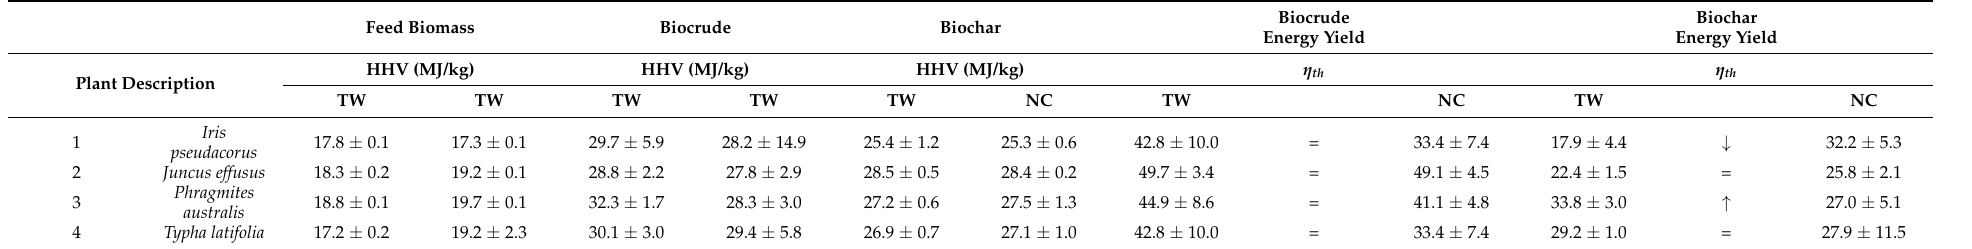
Table 7. Calculated HHV for the feed biomass, biocrude and biochar for the selected plants and the different growing